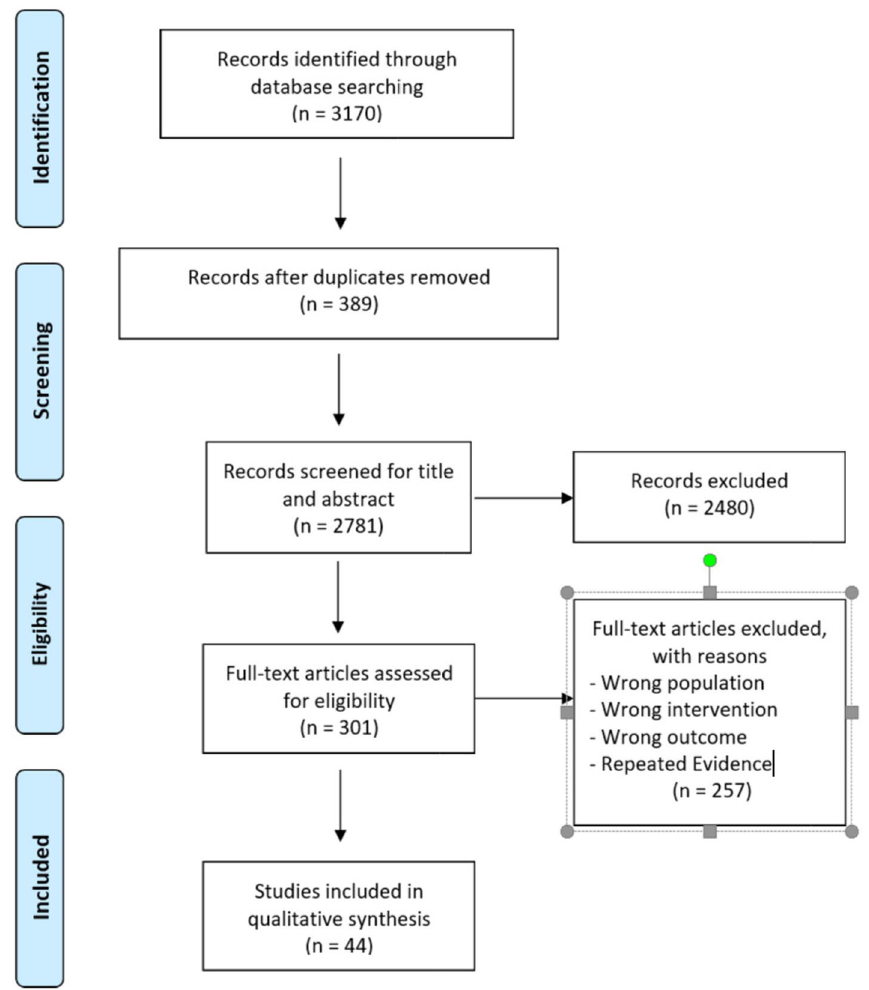
Fig. 1 Flow diagram of the studies’ selection